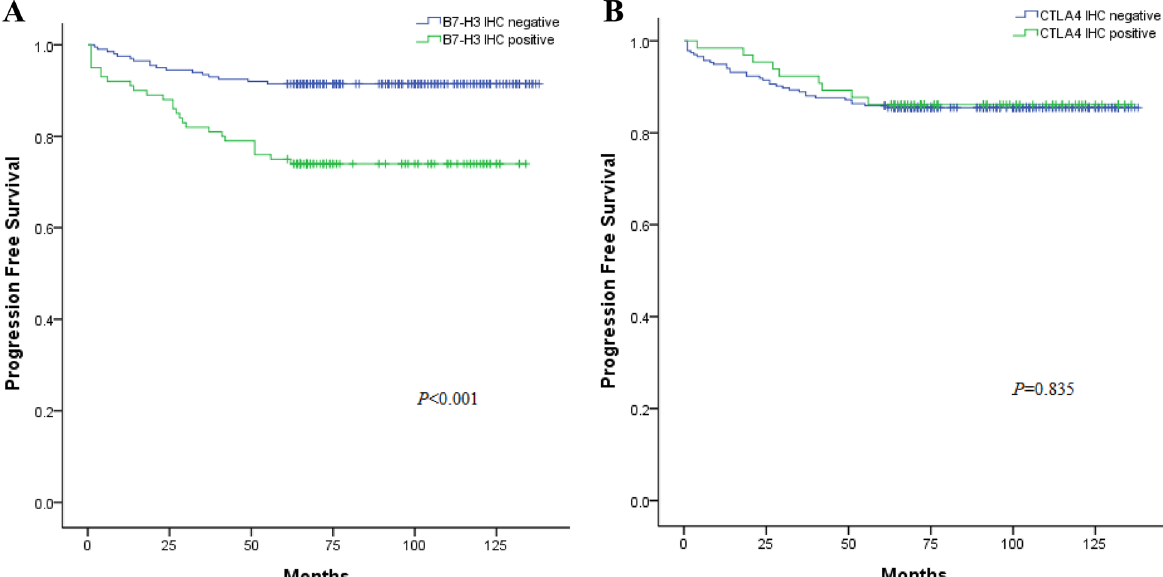
Fig. 3 Progression‑free survival (PFS) curves of RCC patients in the B7‑H3 and CTLA‑4‑positive and ‑negative groups (Kaplan–Meier). The cases were divided into two groups showing positive or negative B7‑H3 ( A ) and CTLA‑4 ( B ) expression. The patients with positive B7‑H3 expression showed poorer overall survival ( P < 0.001) ( A )